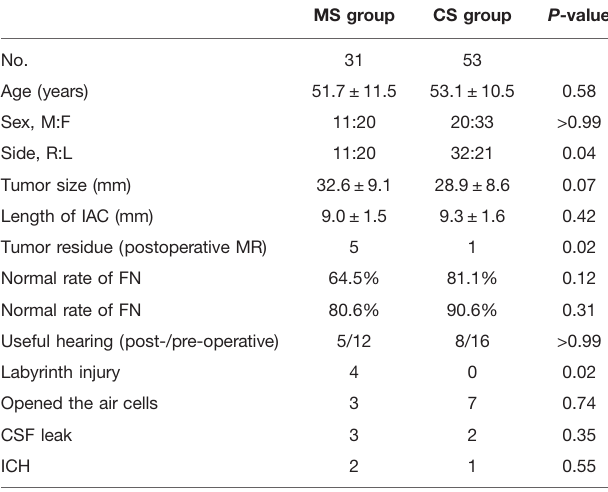
TABLE 1 | Patient characteristics of two groups.